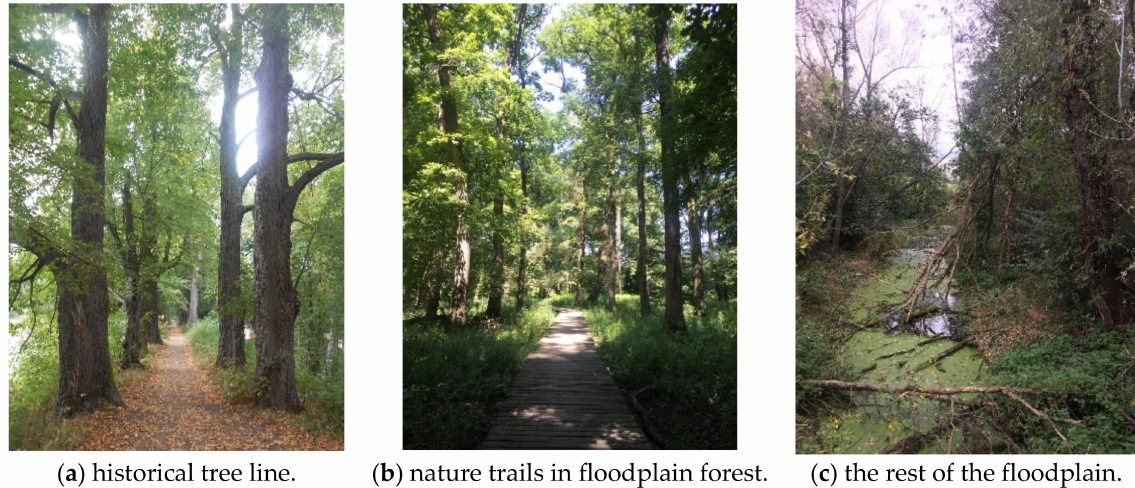
Figure 7. ( a – c ) Alleys in South Moravian region (valuable location—open landscape), university student. Here is an example of a respondent’s statement (illustrated by Figure 8a,b):